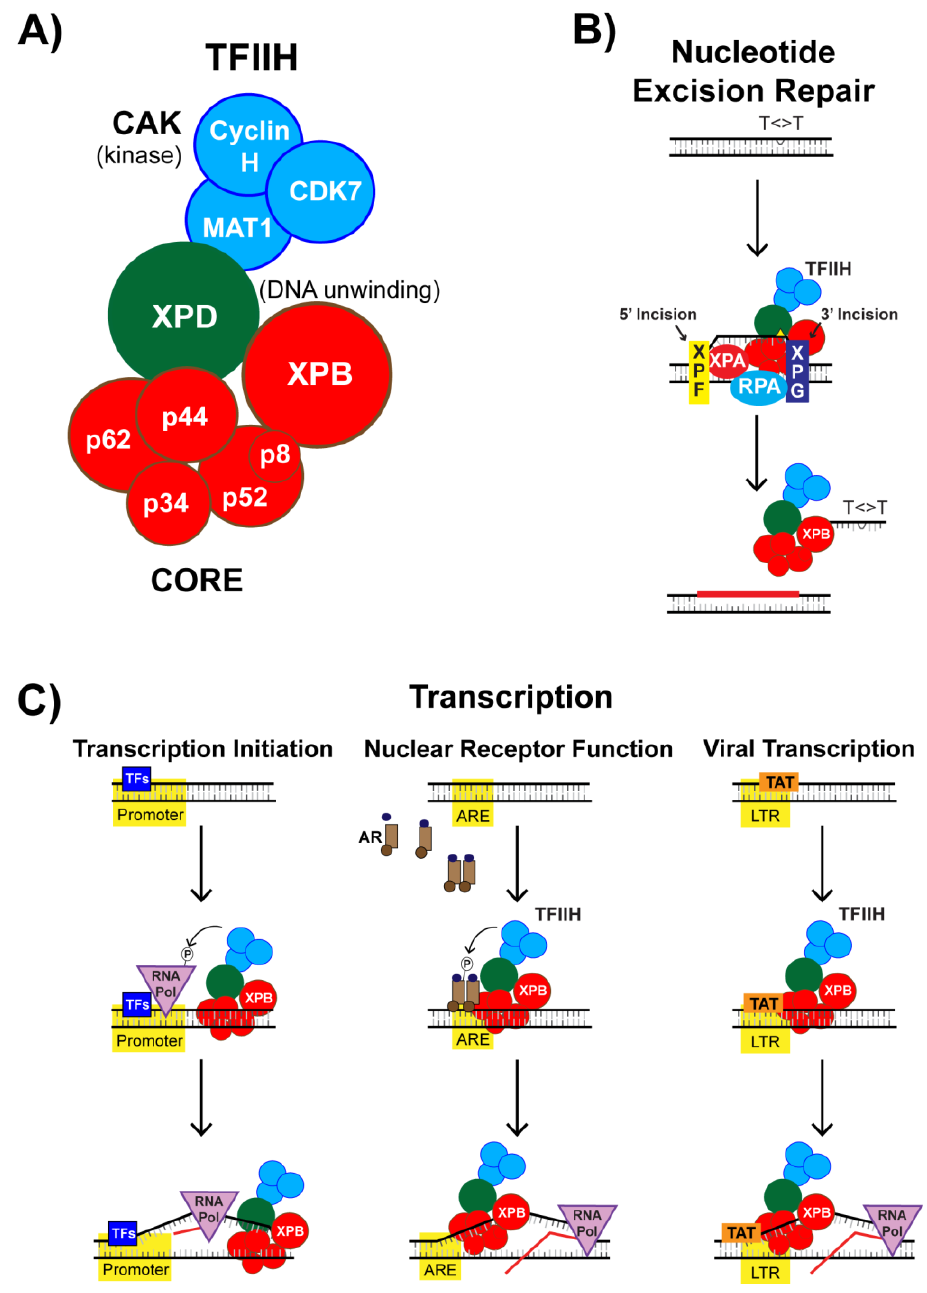
Figure 5. TFIIH structure and function. ( A ) TFIIH (transcription factor II-H) is a 10-subunit protein complex with multiple enzymatic activities, including kinase activity from its cyclin-dependent kinase-activating kinase sub-complex and DNA unwinding activity from the XPD and XPB subunits. ( B ) TFIIH functions in nucleotide excision repair (NER) to unwinding DNA so that the XPF and XPG endonuclease can incise the damage strand of DNA 3′ and 5′ to the lesion, respectively, which releases the damage-containing DNA oligonucleotide in complex with TFIIH. ( C ) TFIIH also functions in general transcription initiation (left), nuclear receptor-dependent transcription (middle), and in viral transcription (right).